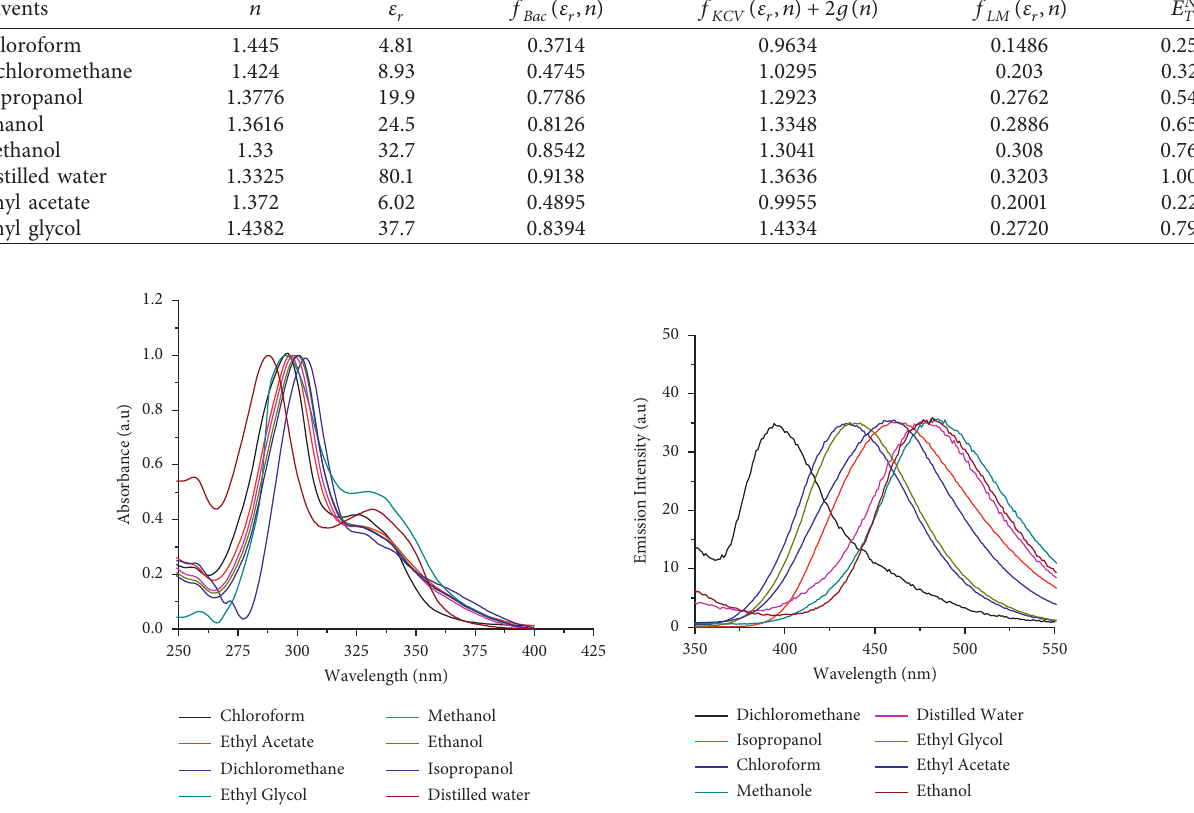
Table 1: Calculated values of solvent polarity functions in different solvents.